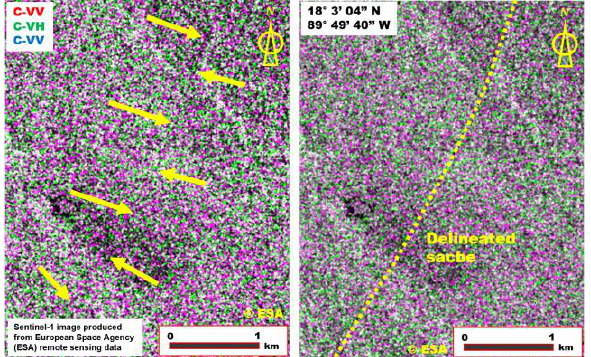
polarized image is displayed in the green channel (Figure 6).